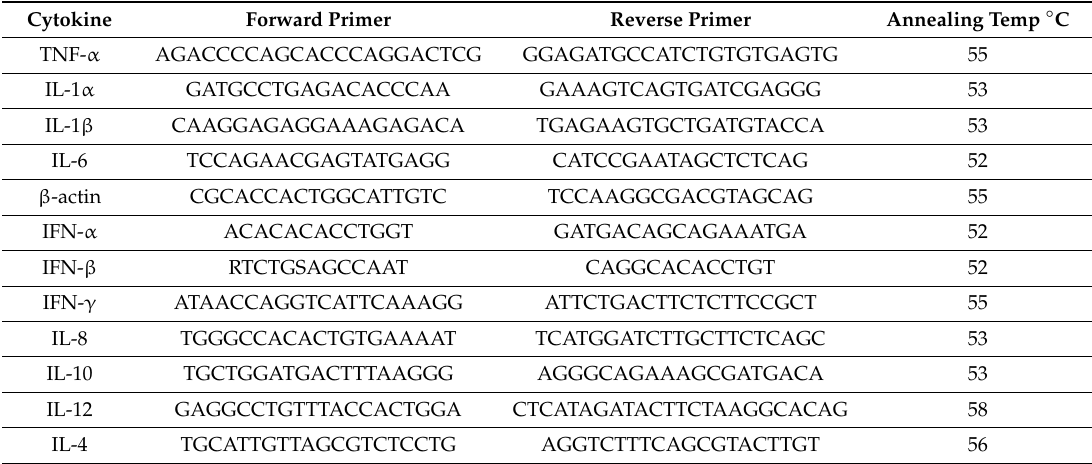
Table 1. The set of primers used for quantifications of apoptosis-related cytokine